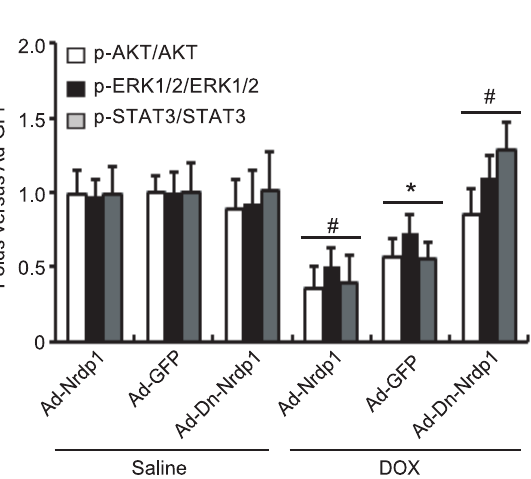
Figure 7. Survival rate. Ten-day survival was analyzed in WT and Nrdp1 TG mice treated with DOX (20 mg/kg). Survival was analyzed by the Kaplan-Meier approach and the log-rank test ( n =15 per group). * P , 0.05 vs WT + saline mice; # P , 0.05 vs WT + DOX mice.